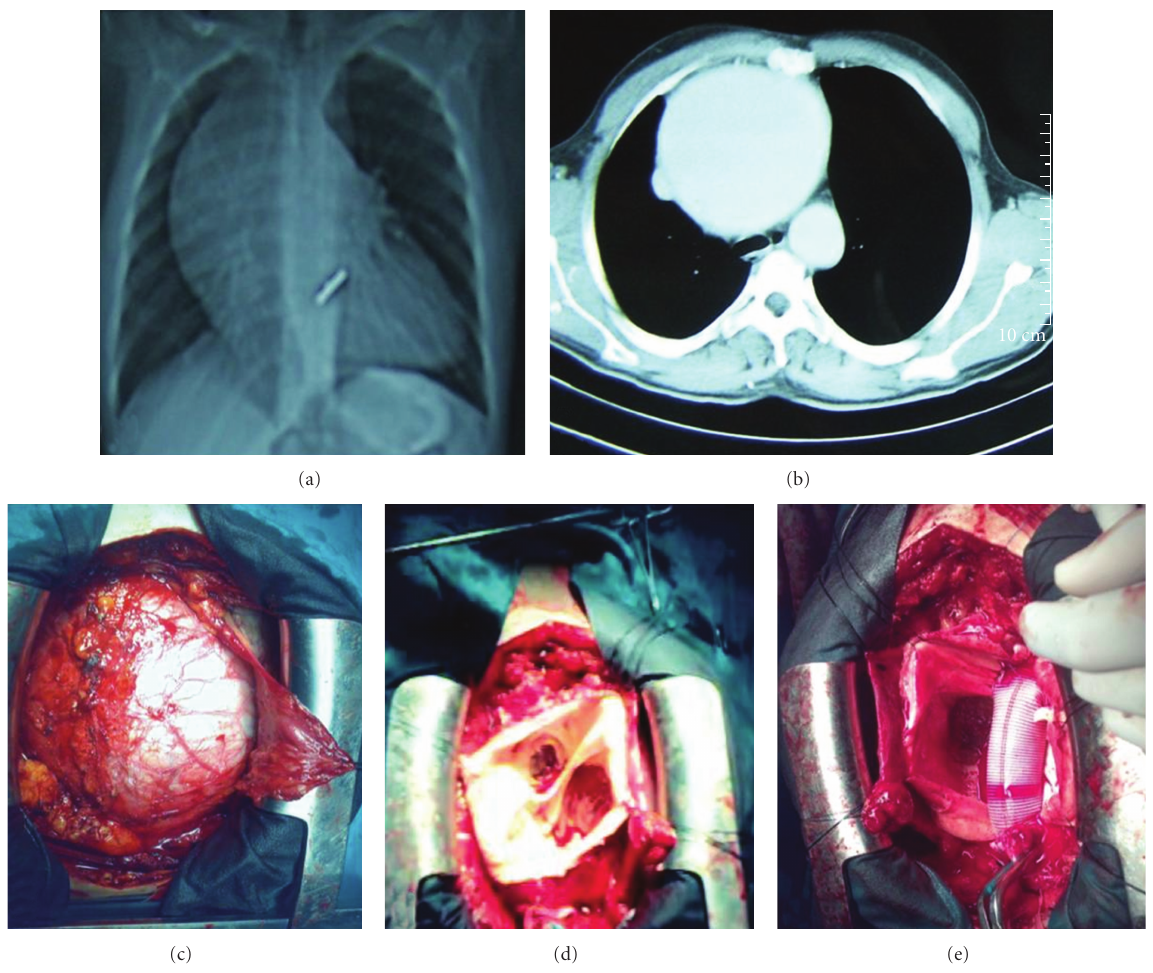
Figure 1: (a) Chest X-ray imaging showing as an aortic enlargement. (b) Spiral thoracic computed tomography imaging showing as a 16-cm aneurysm of ascending aorta. (c) The aortic aneurysm was occupying most of the space in the pericardial cavity. (d) and (e) The aneurysm of the ascending aorta was resected and implanted with a woven graft associated with the left and right coronary artery button